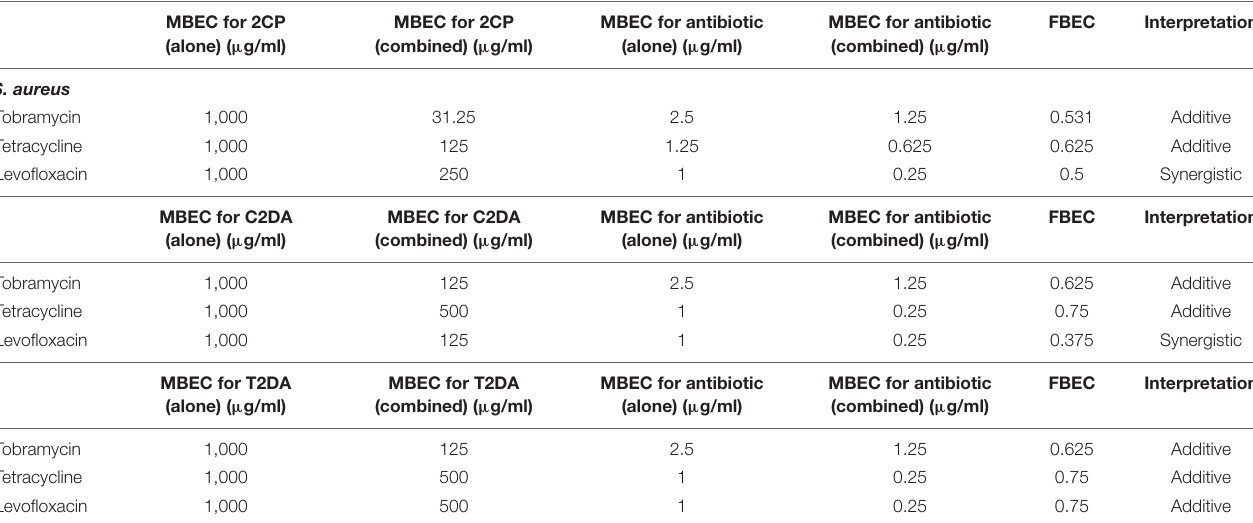
TABLE 3 | S. aureus FBEC index values.